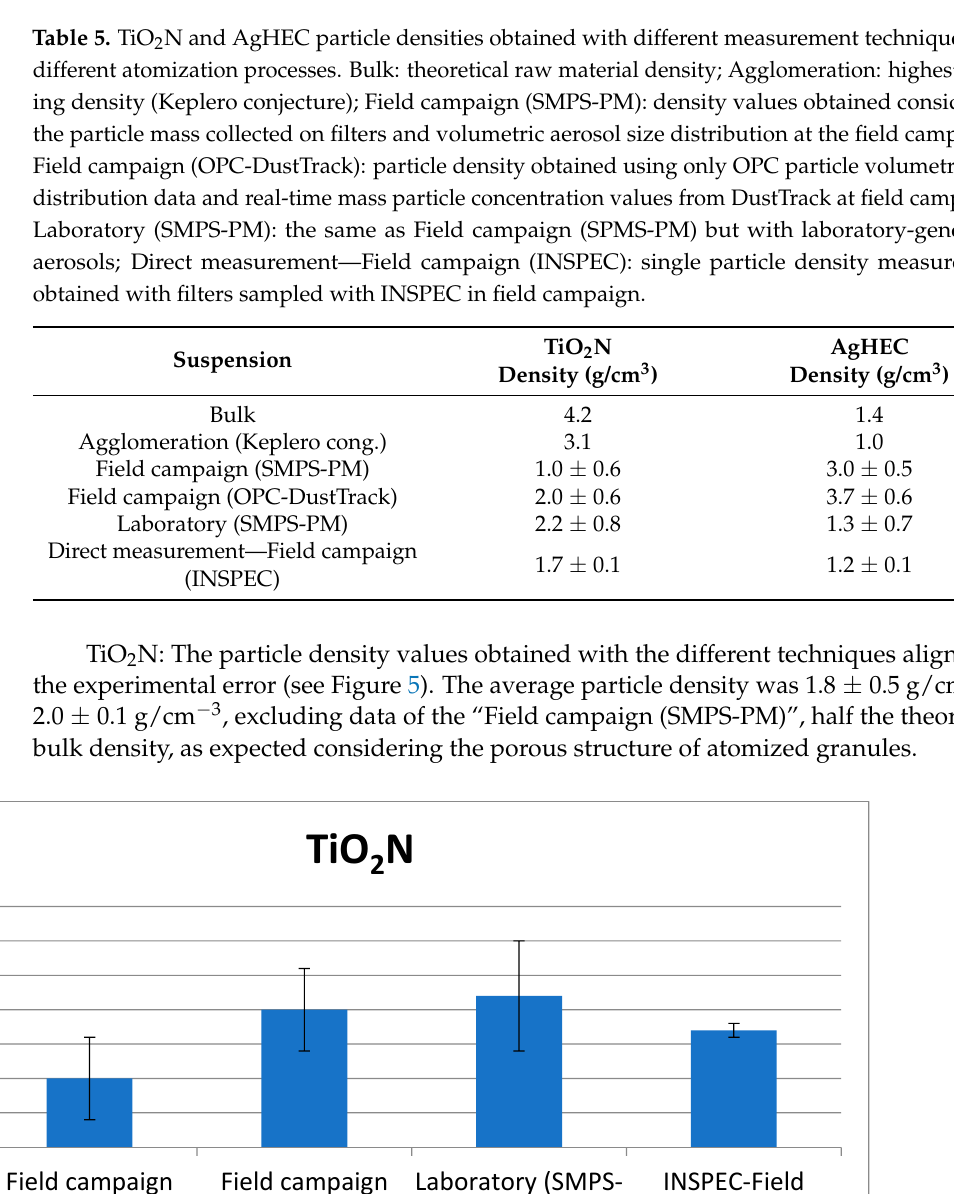
Figure 5. Titanium dioxide atomized particle density values obtained with different techniques and atomization